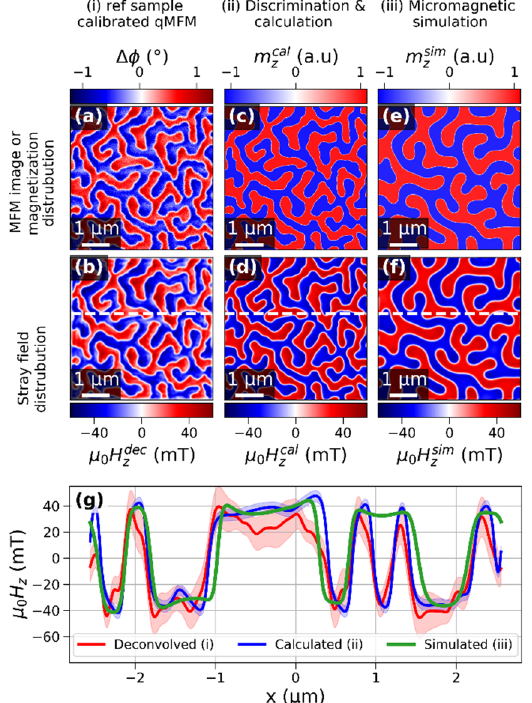
Figure 4. Comparison of simulated and experimental Ti/Pt/Co sample data: ( a ) measured MFM phase shift data and ( b ) perpendicular stray field components B z data calculated using the Co/Pt sample calibrated qMFM; ( c ) z component of the magnetization calculated from a discrimination of the MFM phase shift data from ( a ); ( d ) the thereof calculated perpendicular stray field components B z data using the Ti/Pt/Co micromagnetic material parameters; ( e ) z-component of the magnetization from the micromagnetic simulation and ( f ) the perpendicular stray field components B z data calculated thereof using a layer by layer approach; ( g ) the stray field data with uncertainty bands from the data marked by the dashed lines in the stray field images in ( b , d , f ).